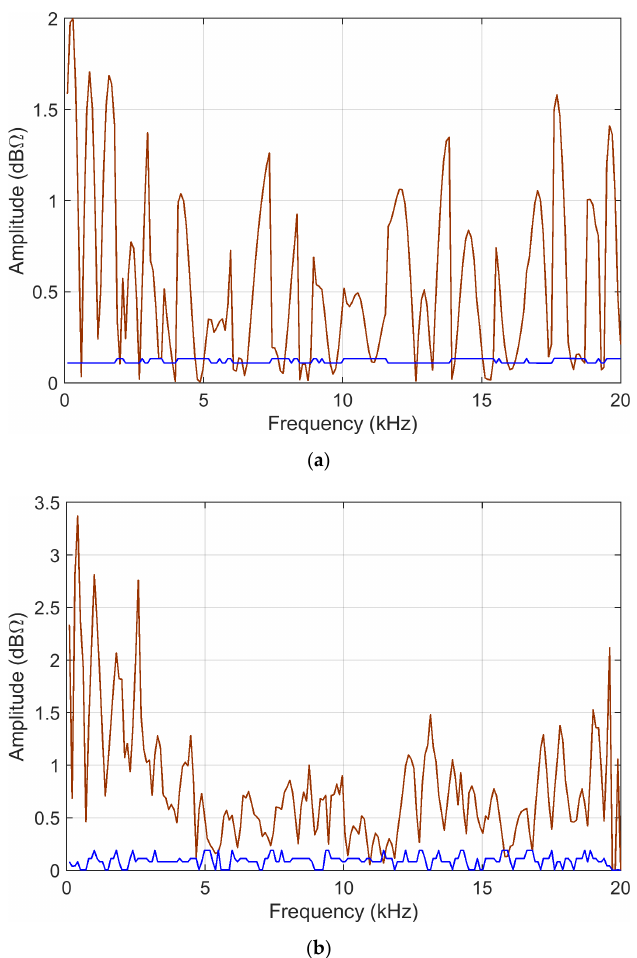
Figure 5. Z (45.0 km) and Z (45.5 km) input data in logarithmic scale: ( a ) ADM i and ( b ) FDM i sensitivity curves, comparing analytical first-order derivative calculation (blue) and normalized standard deviation of MCM output (brown).